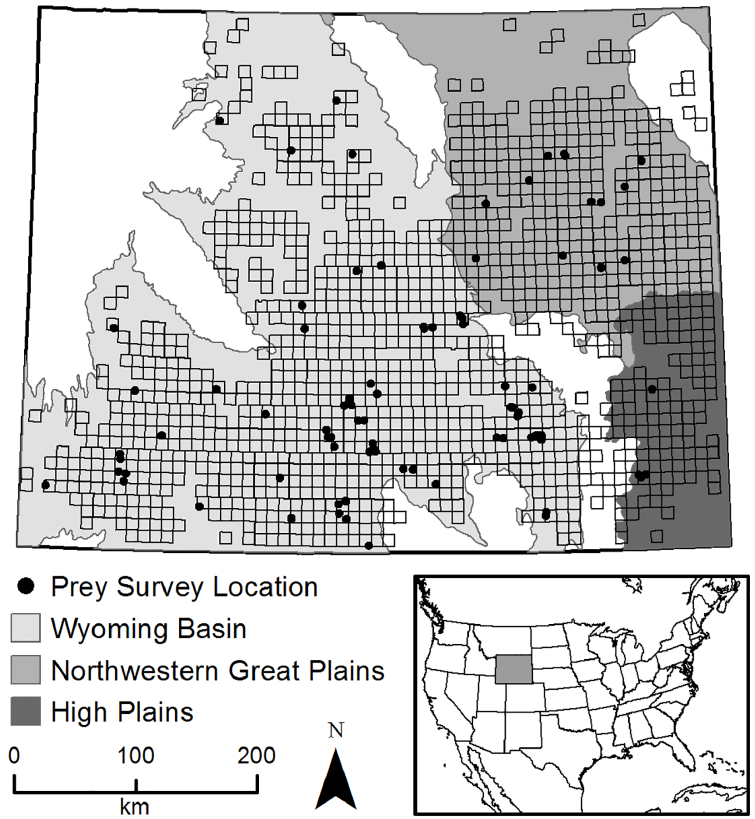
Fig 1. Locations surveyedfor small mammal prey species in three non-mountainous ecoregions of Wyoming, 2010–2012. Survey locationsare shown as block dots, small black squaresshow the extent of the randomly selectedtownshipsin the study area. Inset shows location of Wyoming in the United States. See text for more detailson